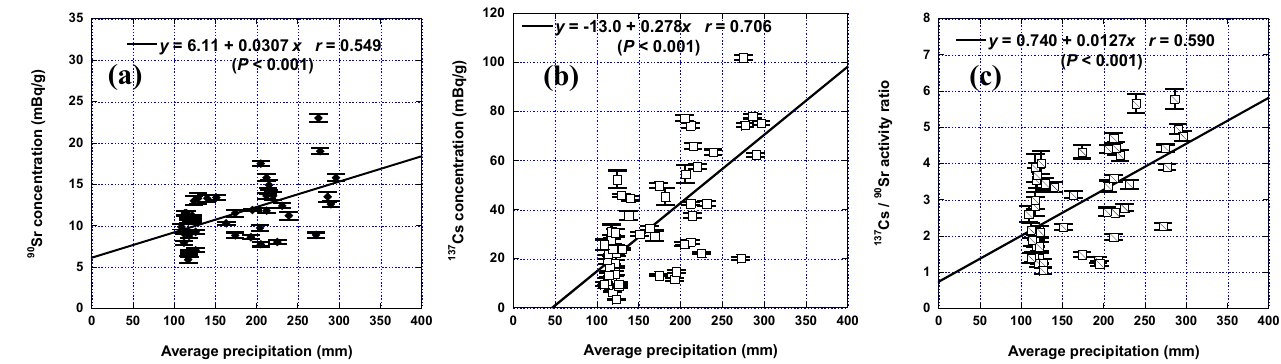
Fig. 3. Relationship between the specific activities of (a) 90 Sr and (b) 137 Cs in Mongolian surface soil samples and estimated average annual precipitation data at the sampling sites. (c) Relationship between the 137 Cs/ 90 Sr activity ratio and precipitation. The error bars indicate counting statistics of 1σ in the measurement. 10 11 Table 1. Specific activities (dry weight basis) for anthropogenic radionuclides and their activity ratio in Mongolian surface soil and compar- ison with related data of surface soils collected in Taklimakan and Tsukuba (other than Mongolian soil, the data cited are based on Igarashi et al., 2005, 2009). All data are decay-corrected as of the time of sample collection in the fall of